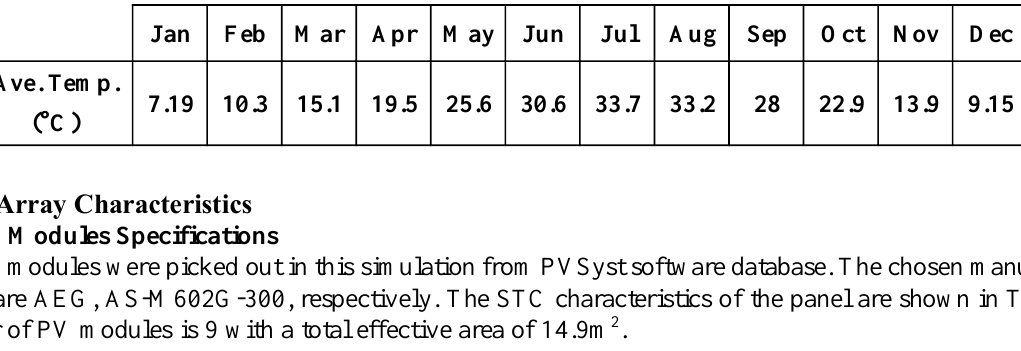
Table 2: Average temperatures for each month at Baghdad location [17].